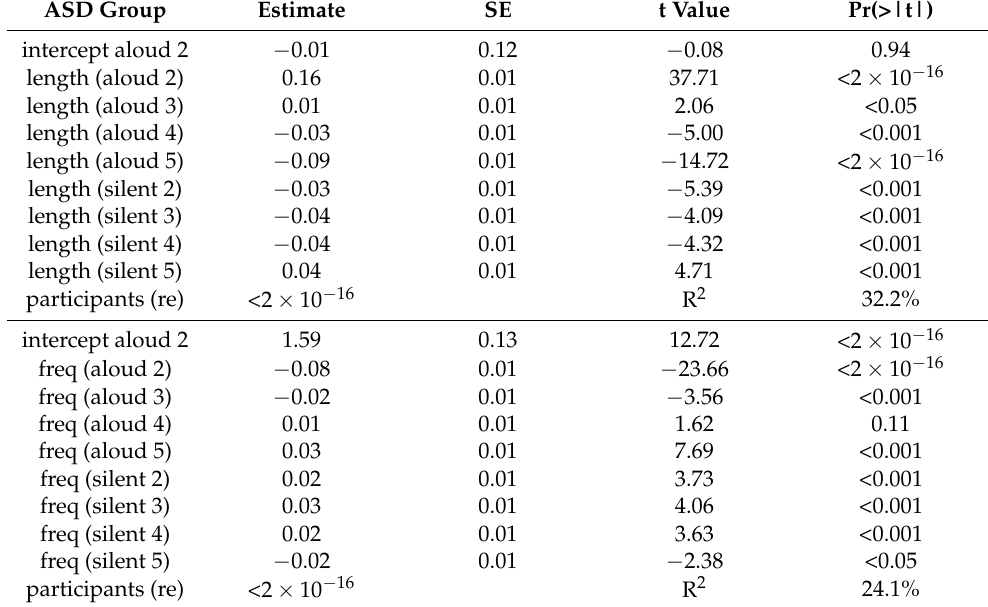
Table 6. GAM coefficients for models fitting tracking time as a function of word length ( length ) or (log)frequency ( freq ) in interaction with grade levels (2, 3, 4, 5), for the two reading modalities. Participants in the ASD group are added as random effects ( re ).